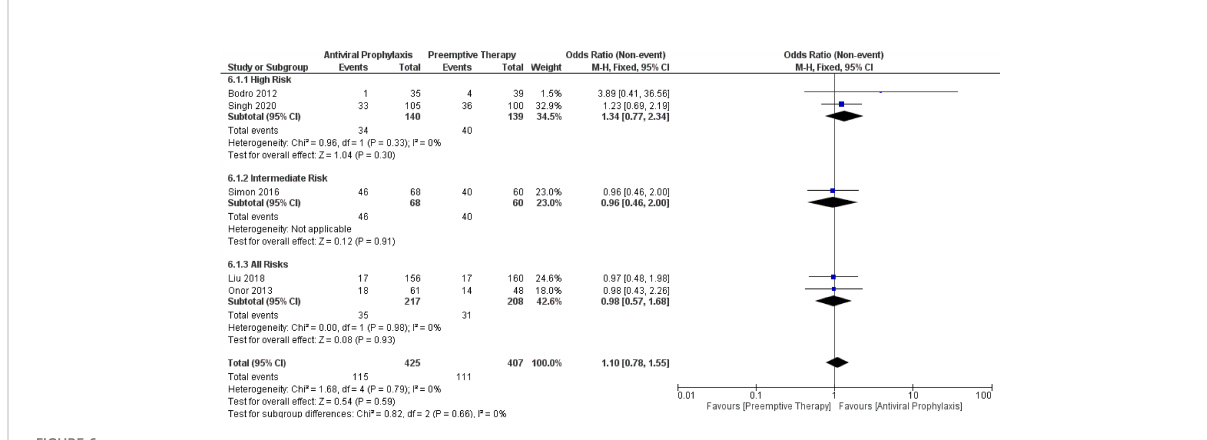
subgroup difference showed heterogeneity (I 2 = 0%; p = 0.48) (Figure 11).